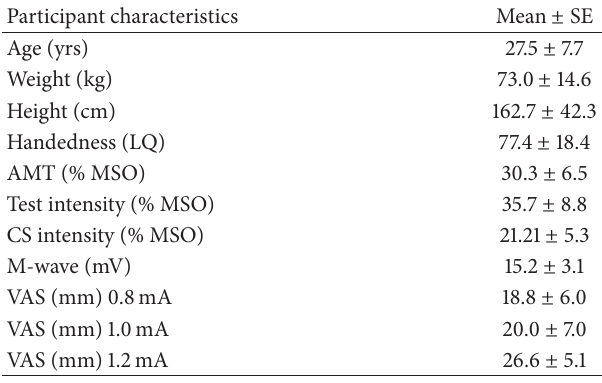
Table 1: Mean ± SE descriptive data prior to anodal tDCS and mean ± SE visual analogue scale obtained during the first 3mins of anodal tDCS during each current intensity.